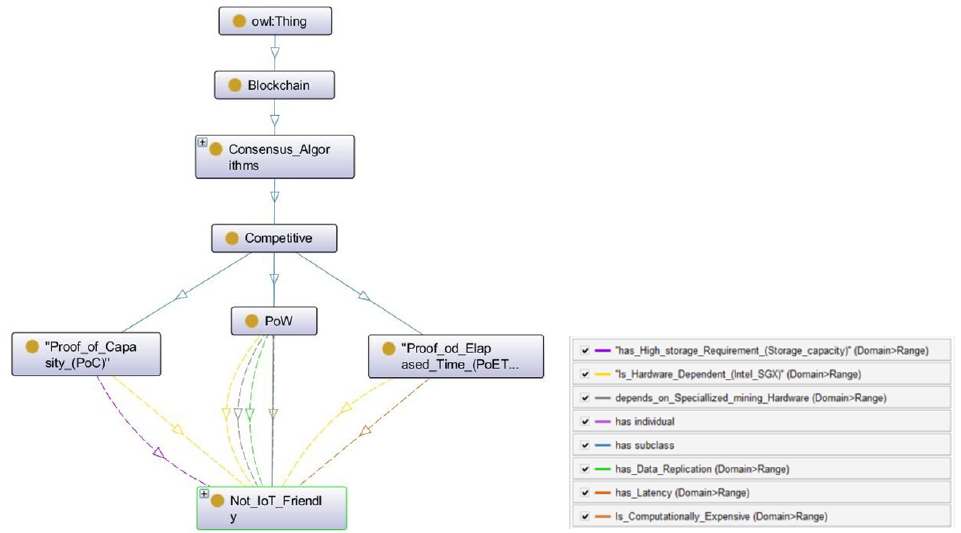
Figure 4. Ontology of competitive consensus class algorithms and IoT